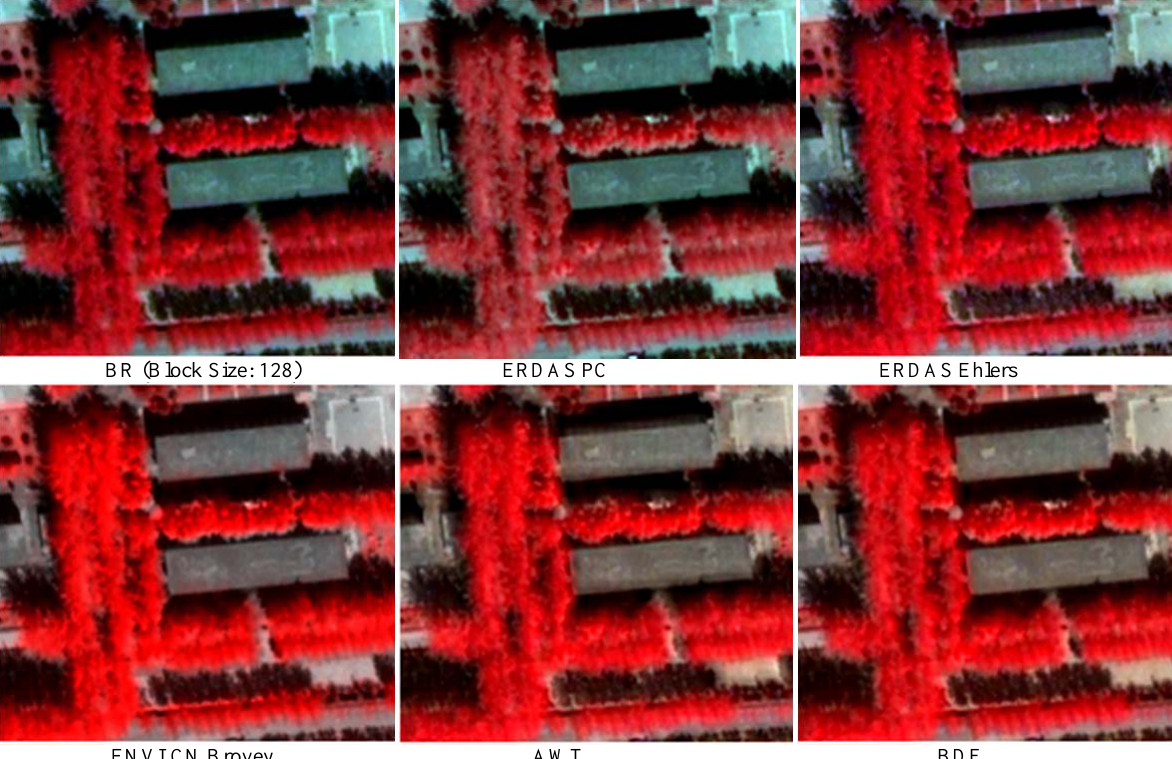
Figure 4. Pan-sharpened QuickBird images using different pan-sharpening